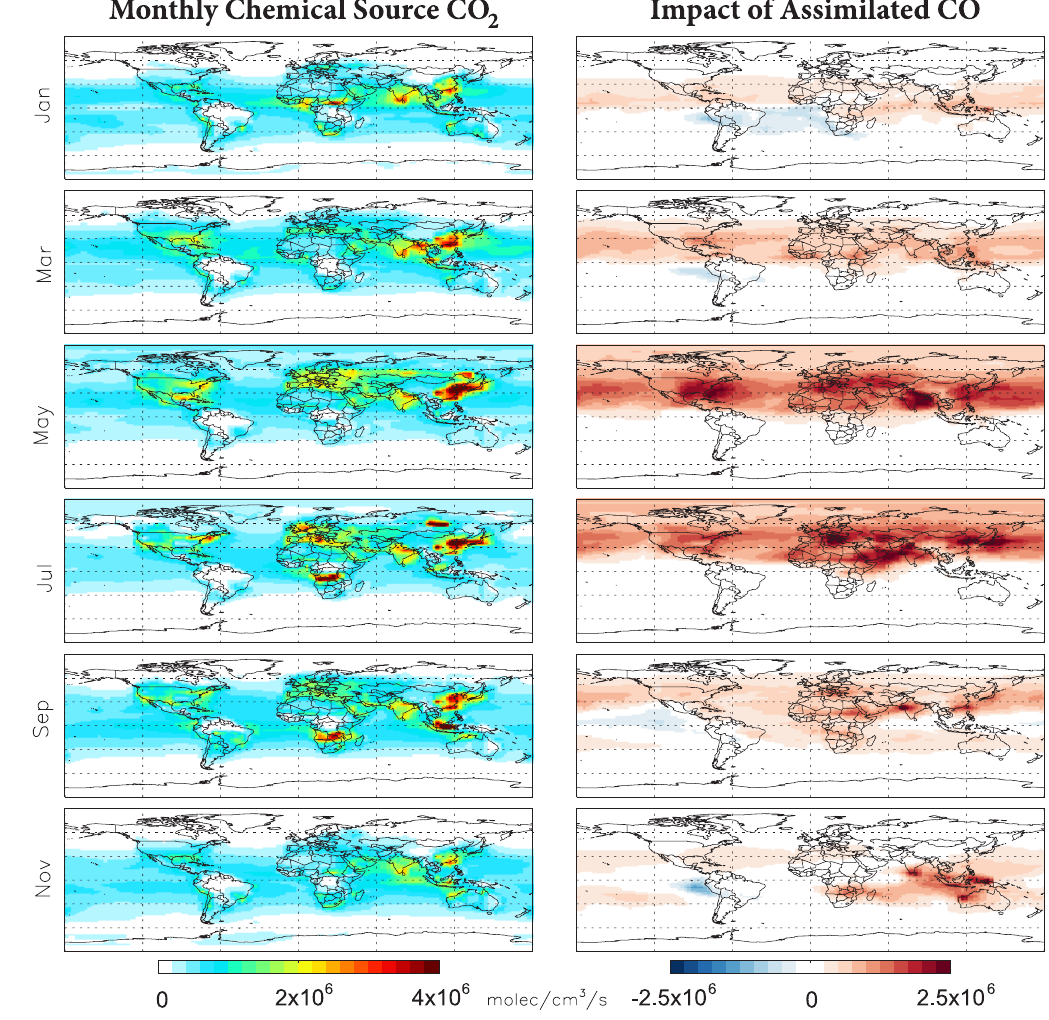
Fig. 7. Monthly CO 2 chemical source production rates in 2006 within the model level nearest to 5km (left). The impact of using assimilated CO relative to the purely modeled chemical production of CO 2 for the same model level